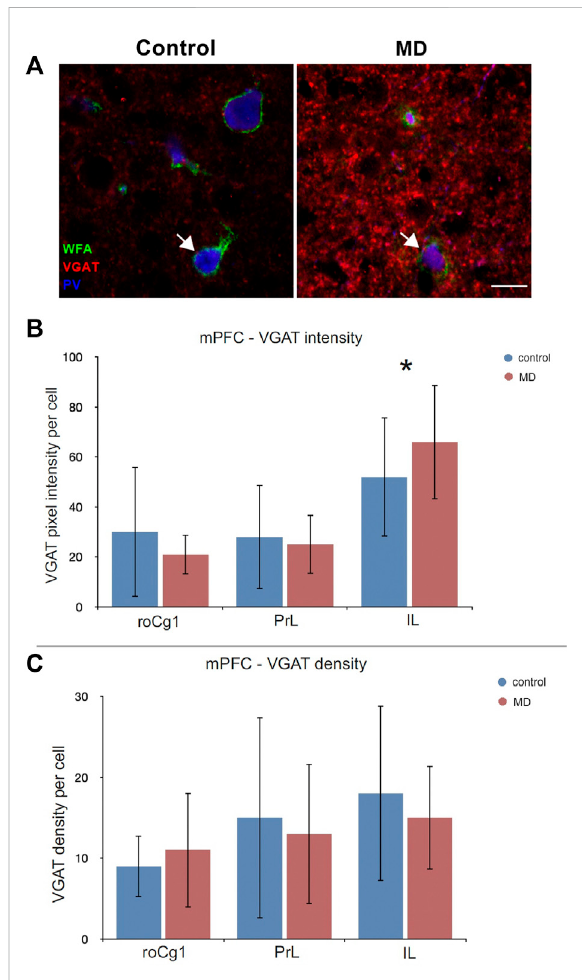
Effects of MD on perisomatic VGAT + puncta intensity and density in the mPFC. (A) Images of triple WFA/VGAT/PV immuno fl uorescenceshowingVGAT+terminalsprojectingonthe PNN+/PV + cells (arrow) in the subregions of the mPFC. Bar charts represent quanti fi cations of the results as means ± SD. MD rats had increased intensity of VGAT + puncta in the IL (B) , and no changes in VGAT density in the mPFC (C) . Total numbers of evaluated cells per animal: roCg1 = 48, PrL = 69, IL = 56. *p < 0.001. Rostral part of area one of cingulate cortex (roCg1), infralimbic cortex (IL), maternally deprived rats (MD), prelimbic cortex (PrL). Scale bar in A = 15 μ